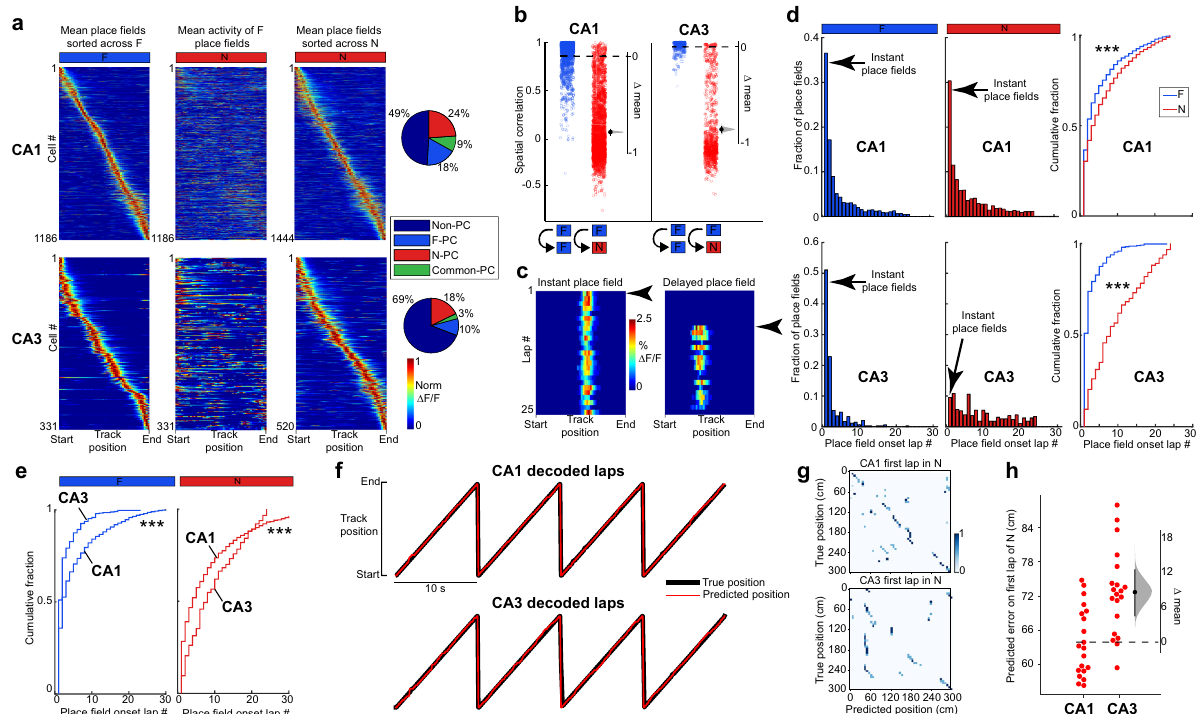
Fig. 2 Place fi eld emergence in novel environments is rapid in CA1 but gradual in CA3. a Left: mean place fi elds (PFs) in F sorted by track position. Middle: mean activity of the same neurons on the left in N. Right: mean place fi elds in N sorted by track position. Far right: percentage of place cells in F and N or common to both from all active neurons. CA1, top panels; CA3, bottom panels. Δ F/F activity is normalized to each neurons ’ maximum transient amplitude. n = 7 sessions in four mice for CA1, n = 13 sessions in seven mice for CA3. Only place cells with single PFs are displayed, but place cells with multiple PFs are included in the pie charts and later analyses. b Pearson ’ s correlation coef fi cient of each cell ’ s average activity map within F (blue, CA1 n = 1392, CA3 n = 320 neurons with activity in both halves of the F session) and between F and N (red, CA1 n = 2283, CA3 n = 698 neurons with activity in both sessions and a PF in one of them). Bootstrapped mean difference ( Δ ) with the distribution of the mean (gray) and 95% con fi dence interval (error bar) on the right of each plot (see Methods). c Example of an instant PF (left) and delayed PF (right) in N. Arrows indicate PF onset lap. d Histograms of PF onset laps in F (left, CA1 n = 1643 PFs, CA3 n = 336 PFs) and N (middle, CA1 n = 1712 PFs, CA3 n = 532 PFs) and cumulative fraction plots for F and N (right). Wilcoxon rank-sum test, two-sided. *** P < 0.001, CA1, P = 3.9 × 10 − 18 , CA3, P = 1.6 × 10 − 55 . e Cumulative fraction plots for CA1 and CA3 PF onset lap in F (left) and in N (right). Wilcoxon rank-sum test, two-sided. *** P < 0.001, F, P = 2.9 × 10 − 13 , N, P = 7.4 × 10 − 13 . f Example mouse showing true track position (black) on laps 37 – 40 and the predicted position (red) decoded by an LSTM decoder (see Methods). CA1, top; CA3, bottom. g Confusion matrix between the predicted ( x axis) and the true ( y axis) position for the fi rst lap in N. h Predicted error on the fi rst lap in N for CA1 and CA3. Each dot represents the decoding error for one decoder trial built based on the activity of 200 randomly chosen place cells from CA1 (left) or CA3 (right). n = 20 decoder trials. Bootstrapped mean difference ( Δ ) with 95% CI (error bar) on the